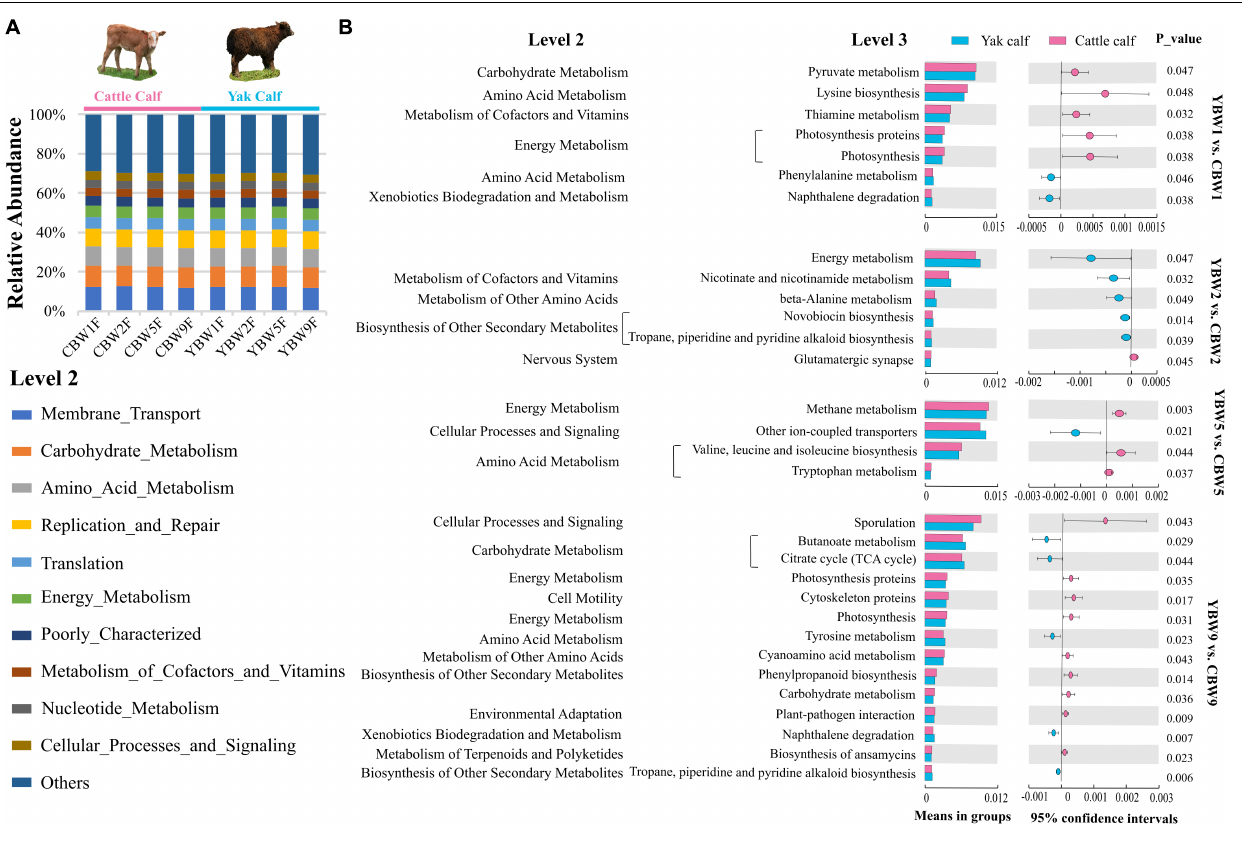
FIGURE 7 | Prediction of potential function of the fecal microbial community in calf using PICRUSt. (A) Relative abundances of level 2 KEGG pathways are described by the age of calves within different species (different weeks after birth) in circular bar plots. (B) The comparison of the function of the fecal microbiota of yak and cattle calves at different weeks after birth based on KEGG level 3 annotation. The statistical significance of the comparison between groups was examined with t -test, and P < 0.05 indicates significant